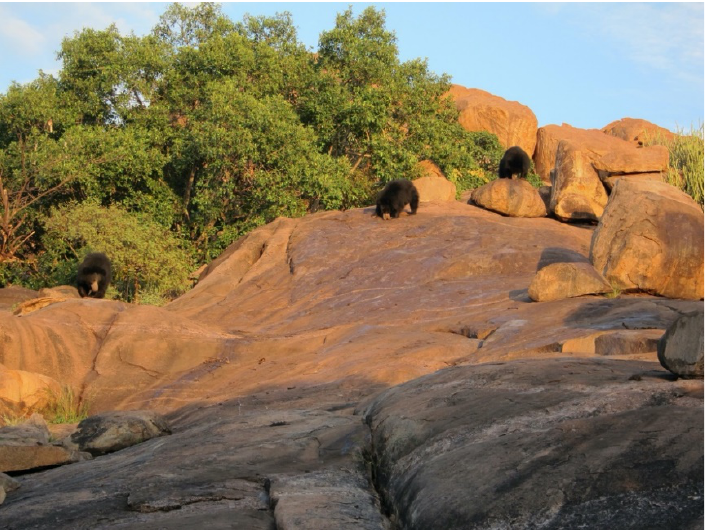
Figure 5. Sloth bears in parts of India regularly use crevices in boulder fields to sleep during the day and come out to feed at dusk. This key habitat offers protection from people and from heat, yet sampling bear sign within this habitat would greatly underestimate its importance. Photo: D.